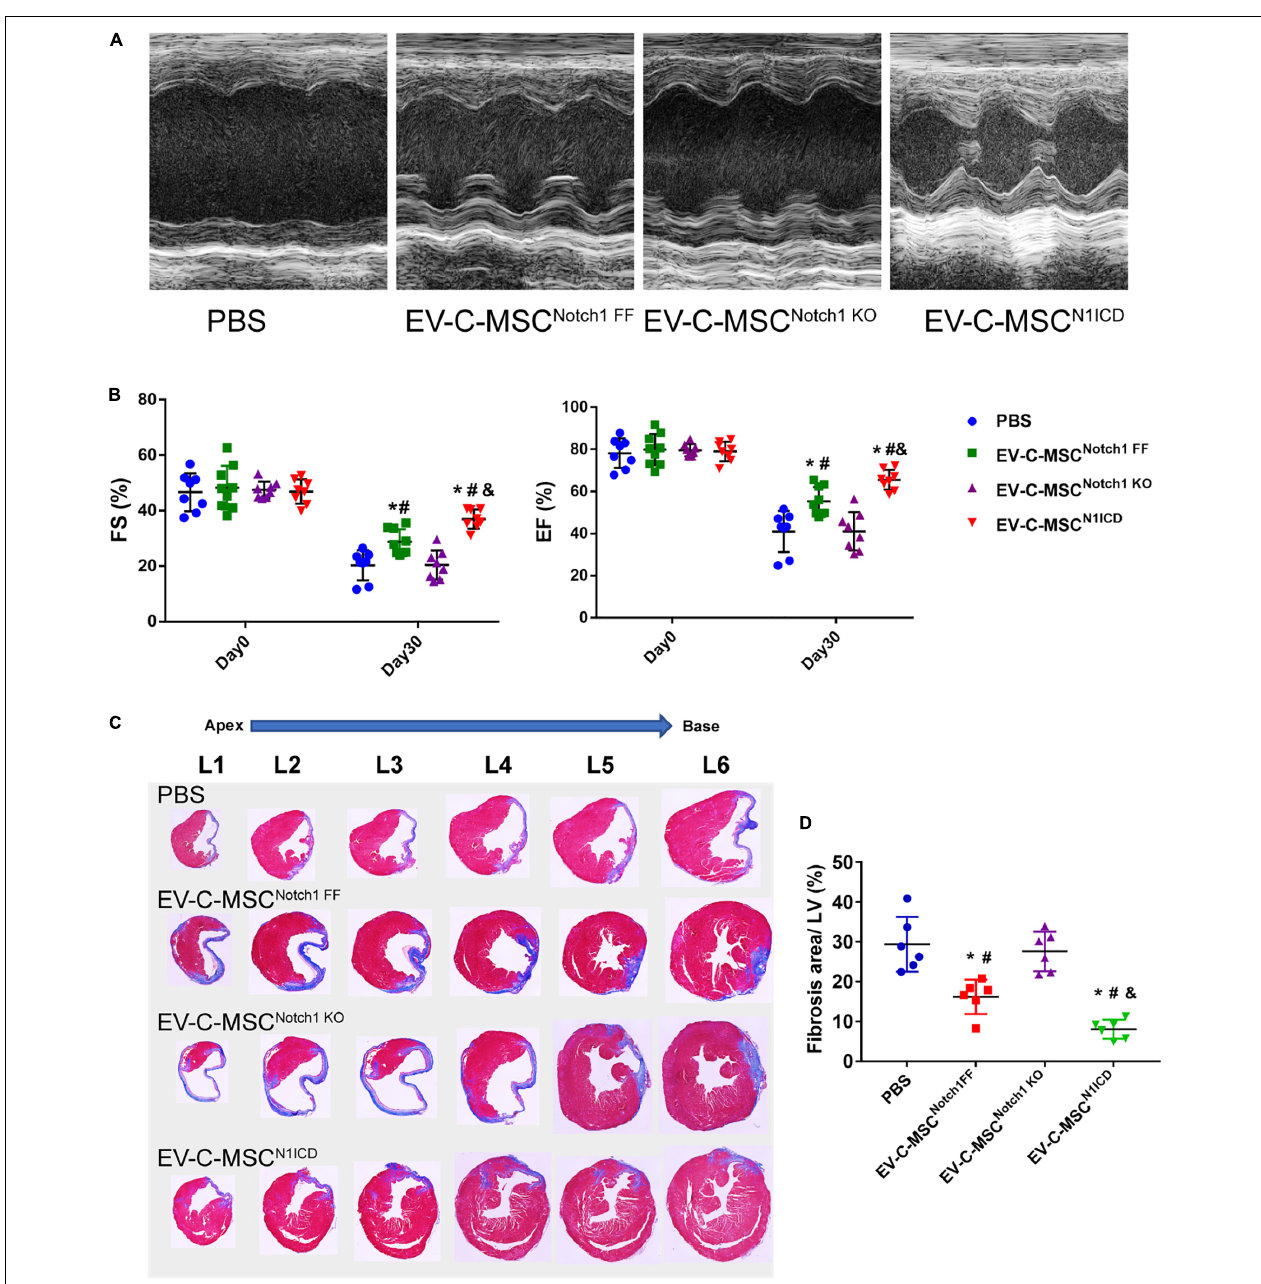
FIGURE 6 | EV-C-MSCs N1ICD improved cardiac function and attenuated cardiac fibrosis after MI. (A) Representative M-mode echocardiography images from different EVs treated. (B) Intramyocardium injection of both EV-C-MSCs Notch1FF and EV-C-MSCs N1ICD improved fraction shortening (FS) and ejection fraction (EF) compared with PBS-treated mice ( P < 0.001). n = 8 in PBS, EV-C-MSC Notch1KO , and EV-C-MSC N1ICD groups; n = 9 in EV-C-MSC Notch1FF group. (C) Representative Masson trichrome-stained sections of hearts from mice treated with EV-C-MSC Notch1FF , EV-C-MSC Notch1KO , and EV-C-MSC N1ICD 1 month after MI. (D) Quantitative analysis of fibrosis size from different treated mice 1 month after MI. EV-C-MSCs N1ICD significantly decreased fibrosis size compared with other groups, respectively. * vs. PBS group, # vs. EV-C-MSC Notch1KO group, & vs. EV-C-MSC Notch1FF group, P < 0.01. n = 6.